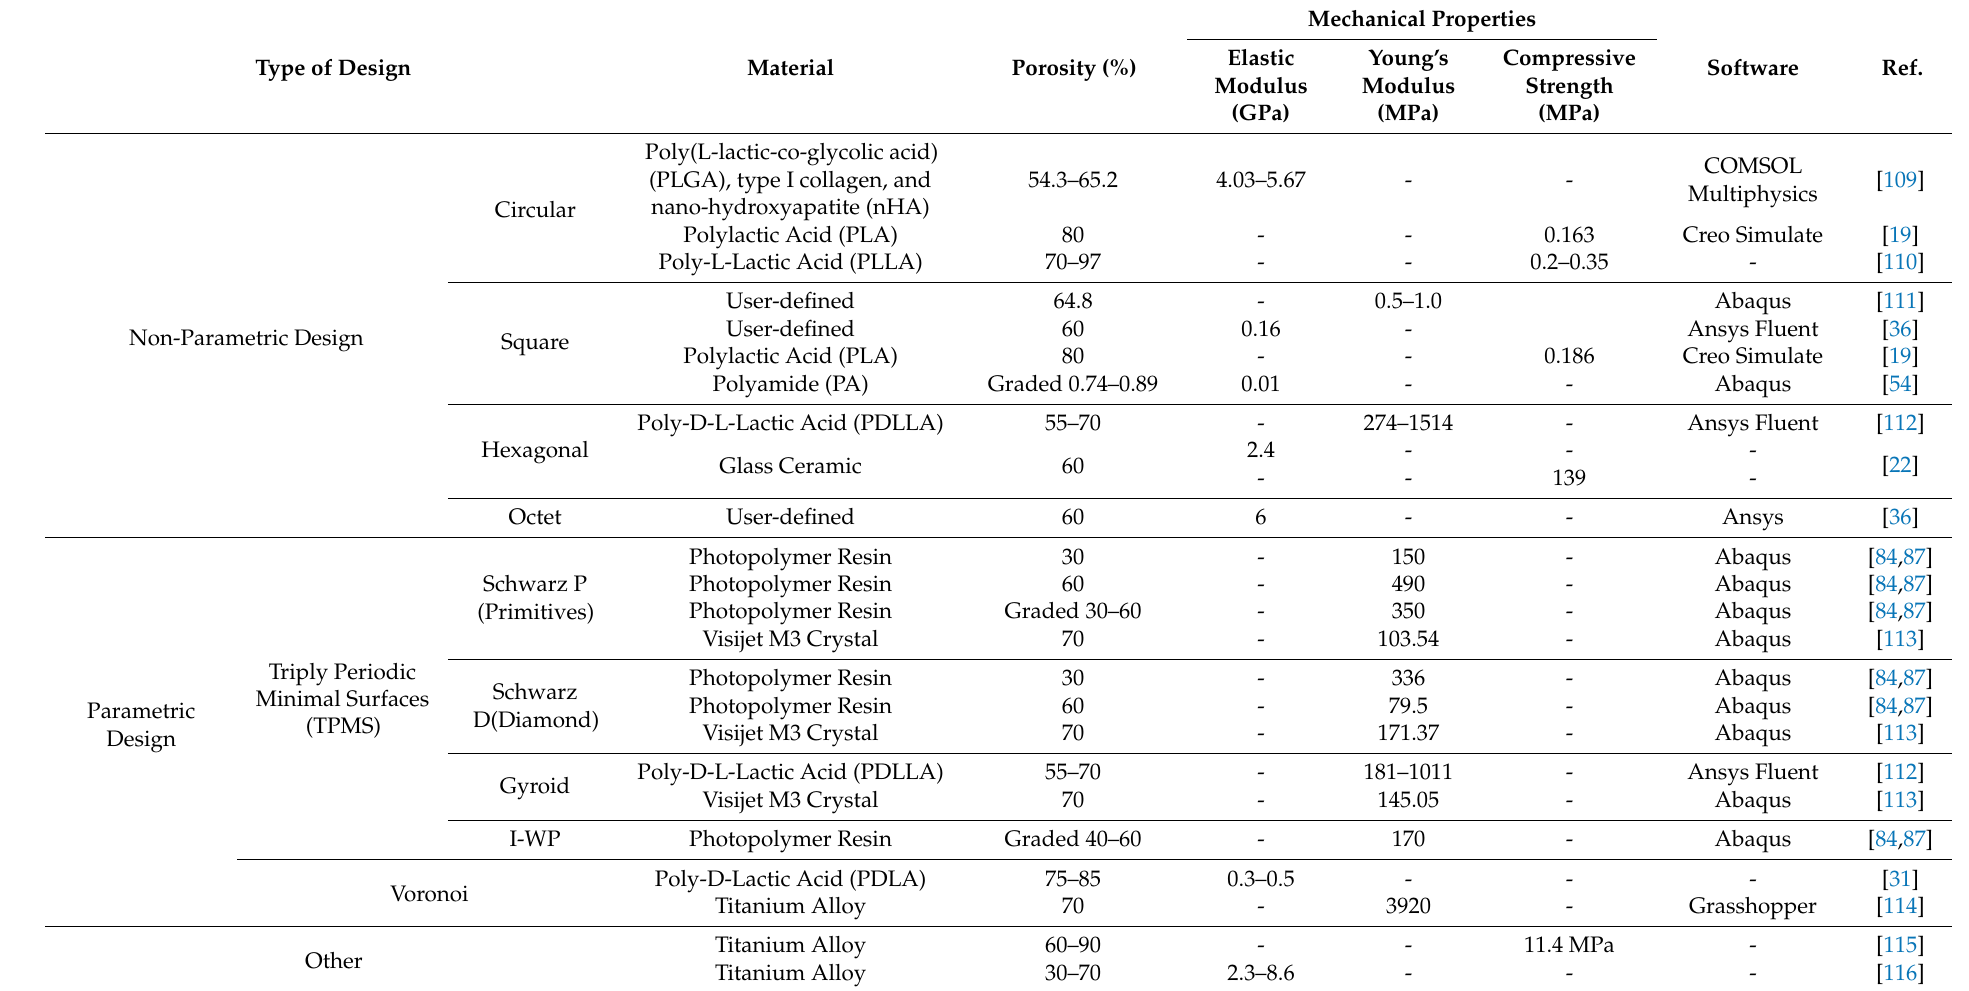
Table 4. Scaffold design and its